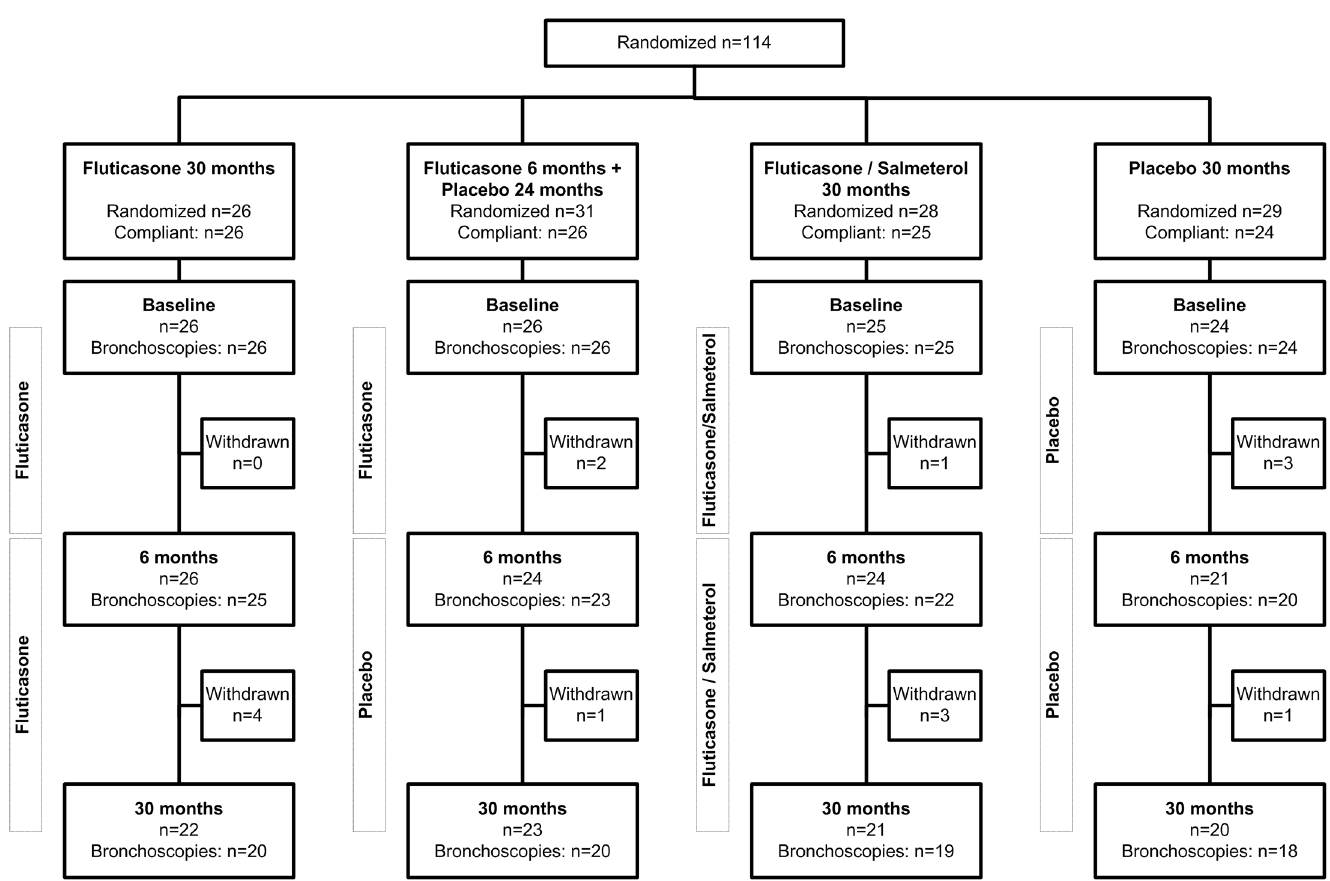
Fig 1. Study flow diagram. Total number of patients randomized and compliant ( > 70% medication use) per treatment group. At each stage of the study (0, 6 and 30 months) the numbers are listed of those who underwent bronchoscopy amongst the number of patients remaining in the study. We reproduced this flowchart from ‘ Lapperre TS et al. (2009) Effect of fluticasone with and without salmeterol on pulmonary outcomes in chronic obstructive pulmonary disease: a randomized trial. Ann Intern Med 151: 517 – 527, with permission ’ .